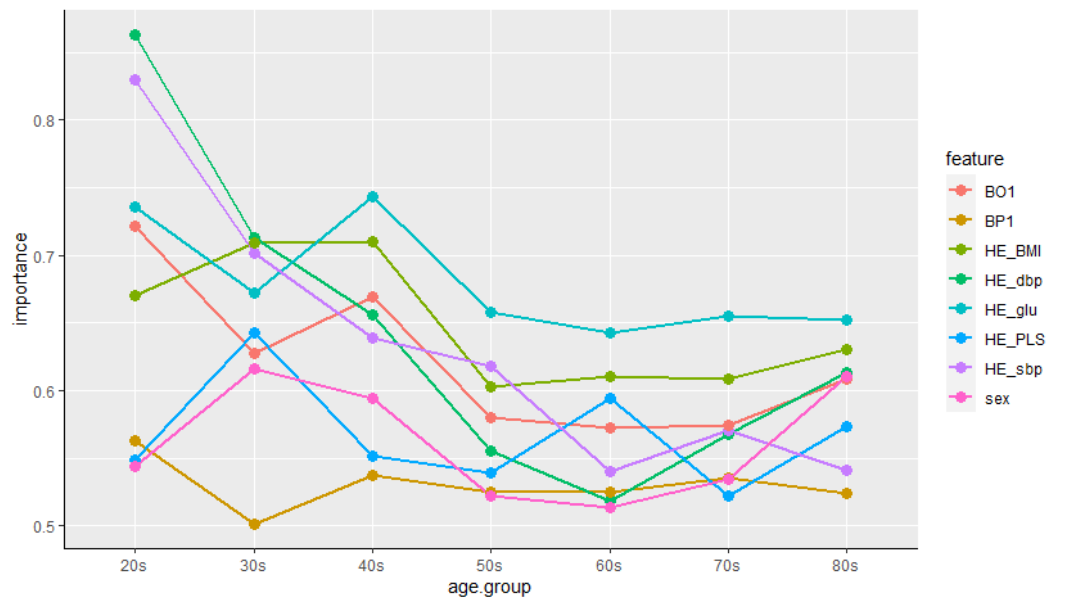
Figure 4. Features’ importance by age group. Table 6. Features’ importance according to